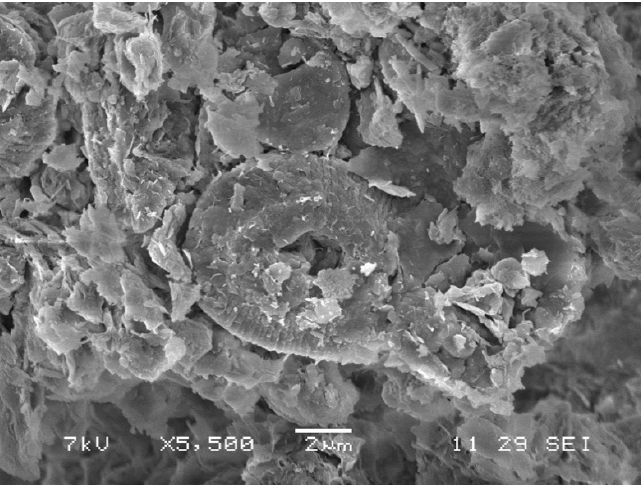
Figure 13. SEM of marine deposited clay sample.